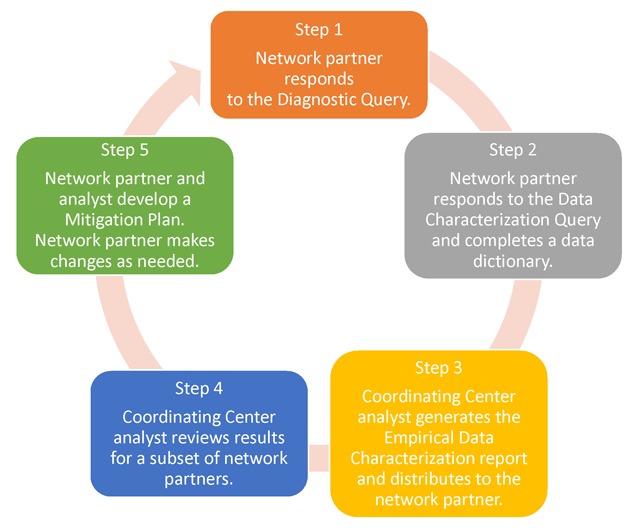
Data Curation Cycle.